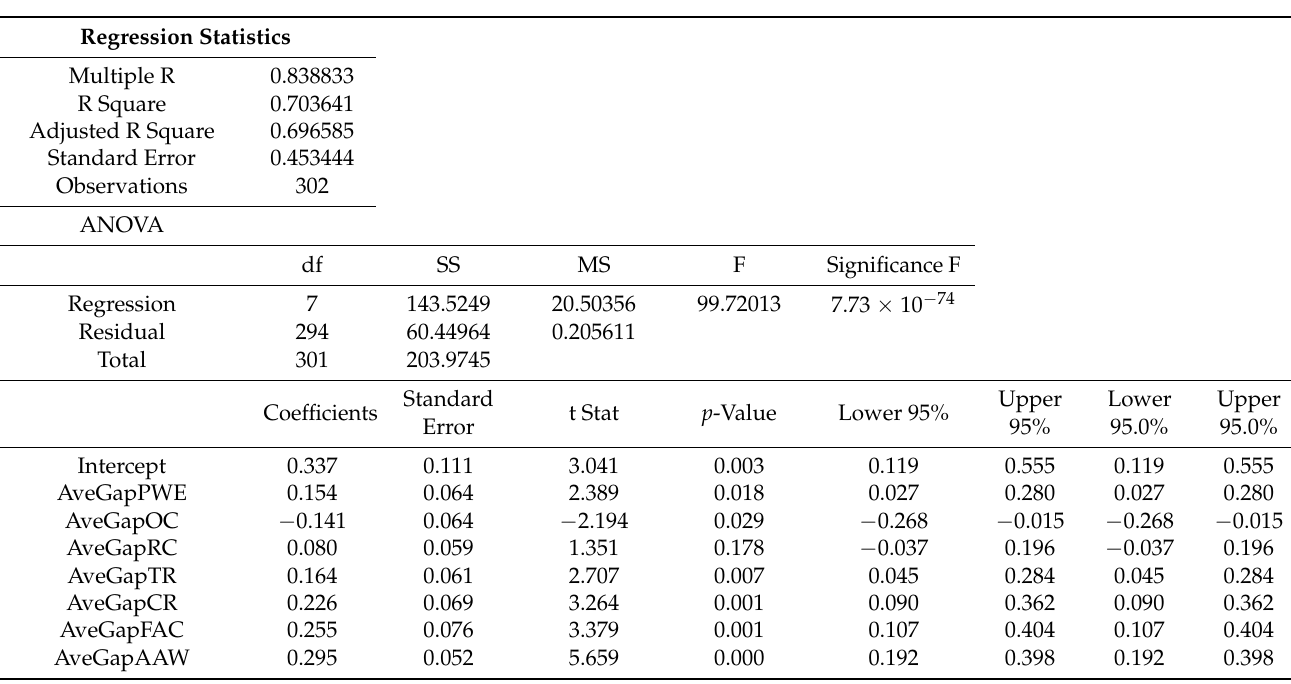
Table 10. Regression